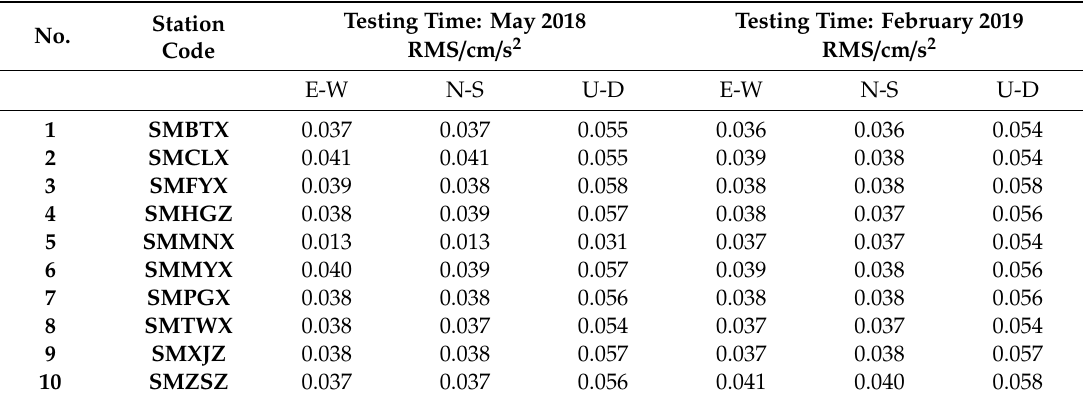
Table 3. Self-noise RMS of the